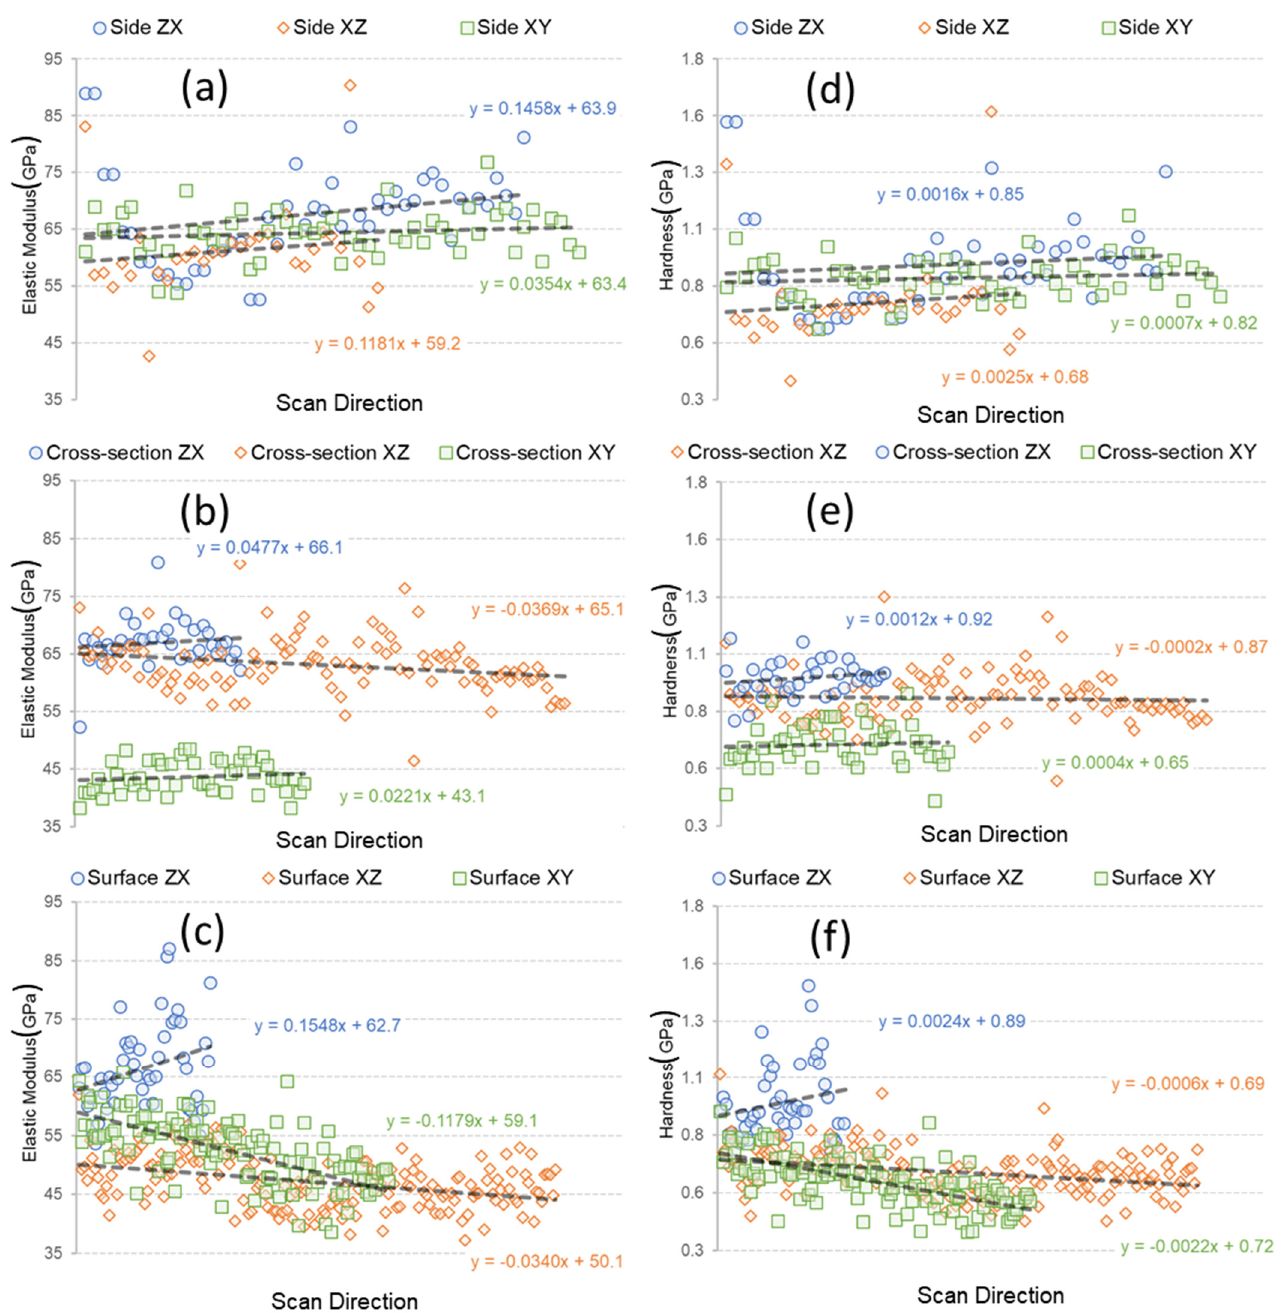
Figure 6. Young’s modulus ( a – c ) and hardness ( d – f ) estimates (derived from Oliver–Pharr nanoindentation tests) in 3D-printed RS-333 Al alloy.